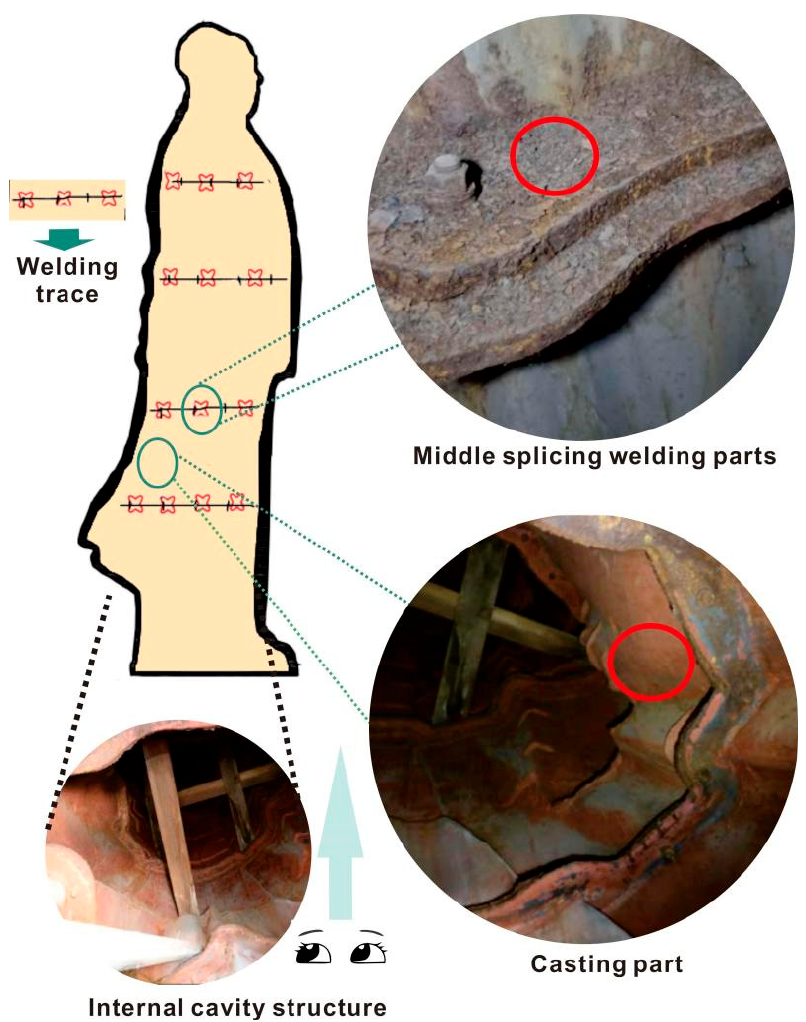
Figure 2. Sampling location of Chairman MAO Statue (The red circle is the sampling location).